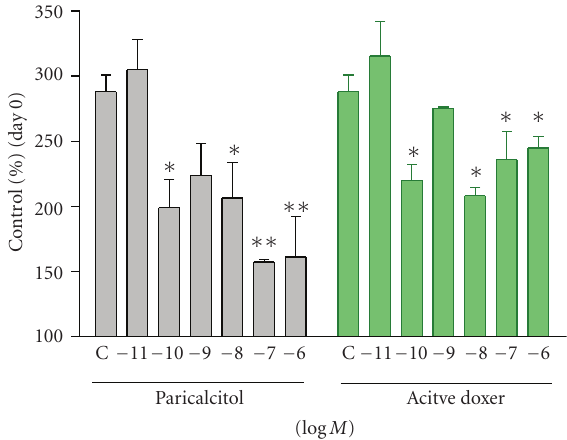
Figure 6: E ff ect of paricalcitol and active doxercalciferol on the proliferation of pig parathyroid cells. Cells were treated with or without increasing concentrations of paricalcitol or active doxercalciferol (doxer) for 72 hours. Data were expressed as % of control (cells on Day 0, 100%). Each value shown is mean ± the standard deviation ( n = 4–8). One way ANOVA Dunnett test with 95% confidence intervals of di ff erence was performed for statistical comparisons. ∗ P < . 05, ∗∗ P < . 01 versus Control (C, no drug